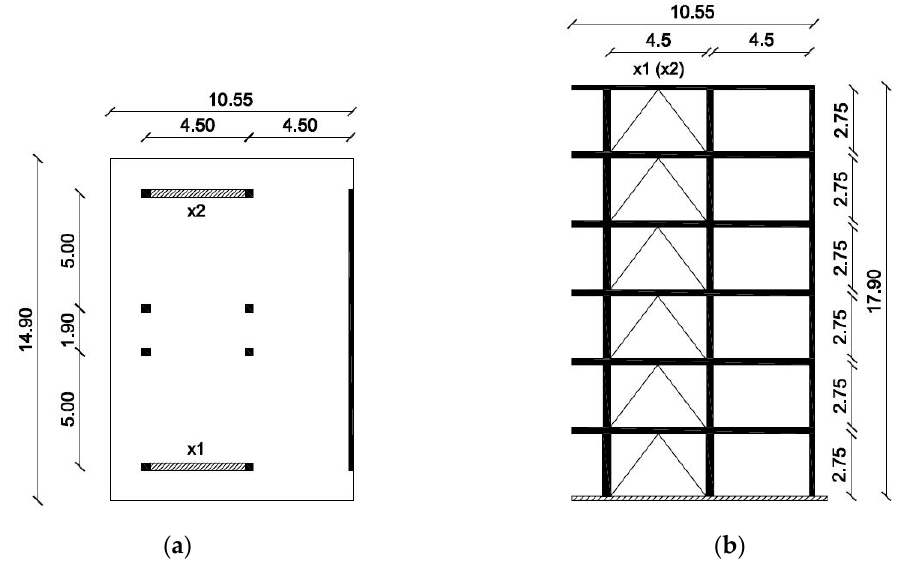
Figure 18. Distribution of Jarret devices in: ( a ) plan and ( b ) elevation.